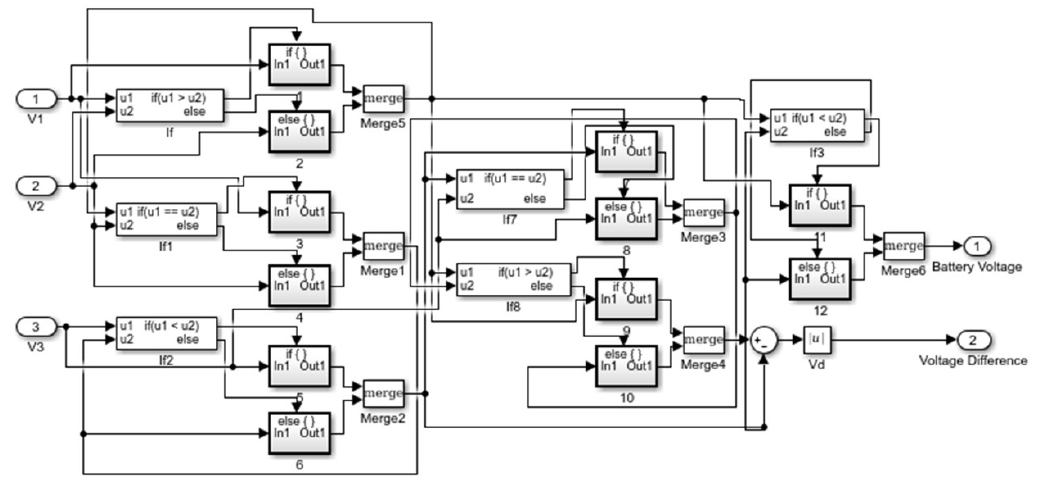
Figure 8. Finding the largest voltage difference of the cells (V d ) and the lowest battery voltage (V B ).